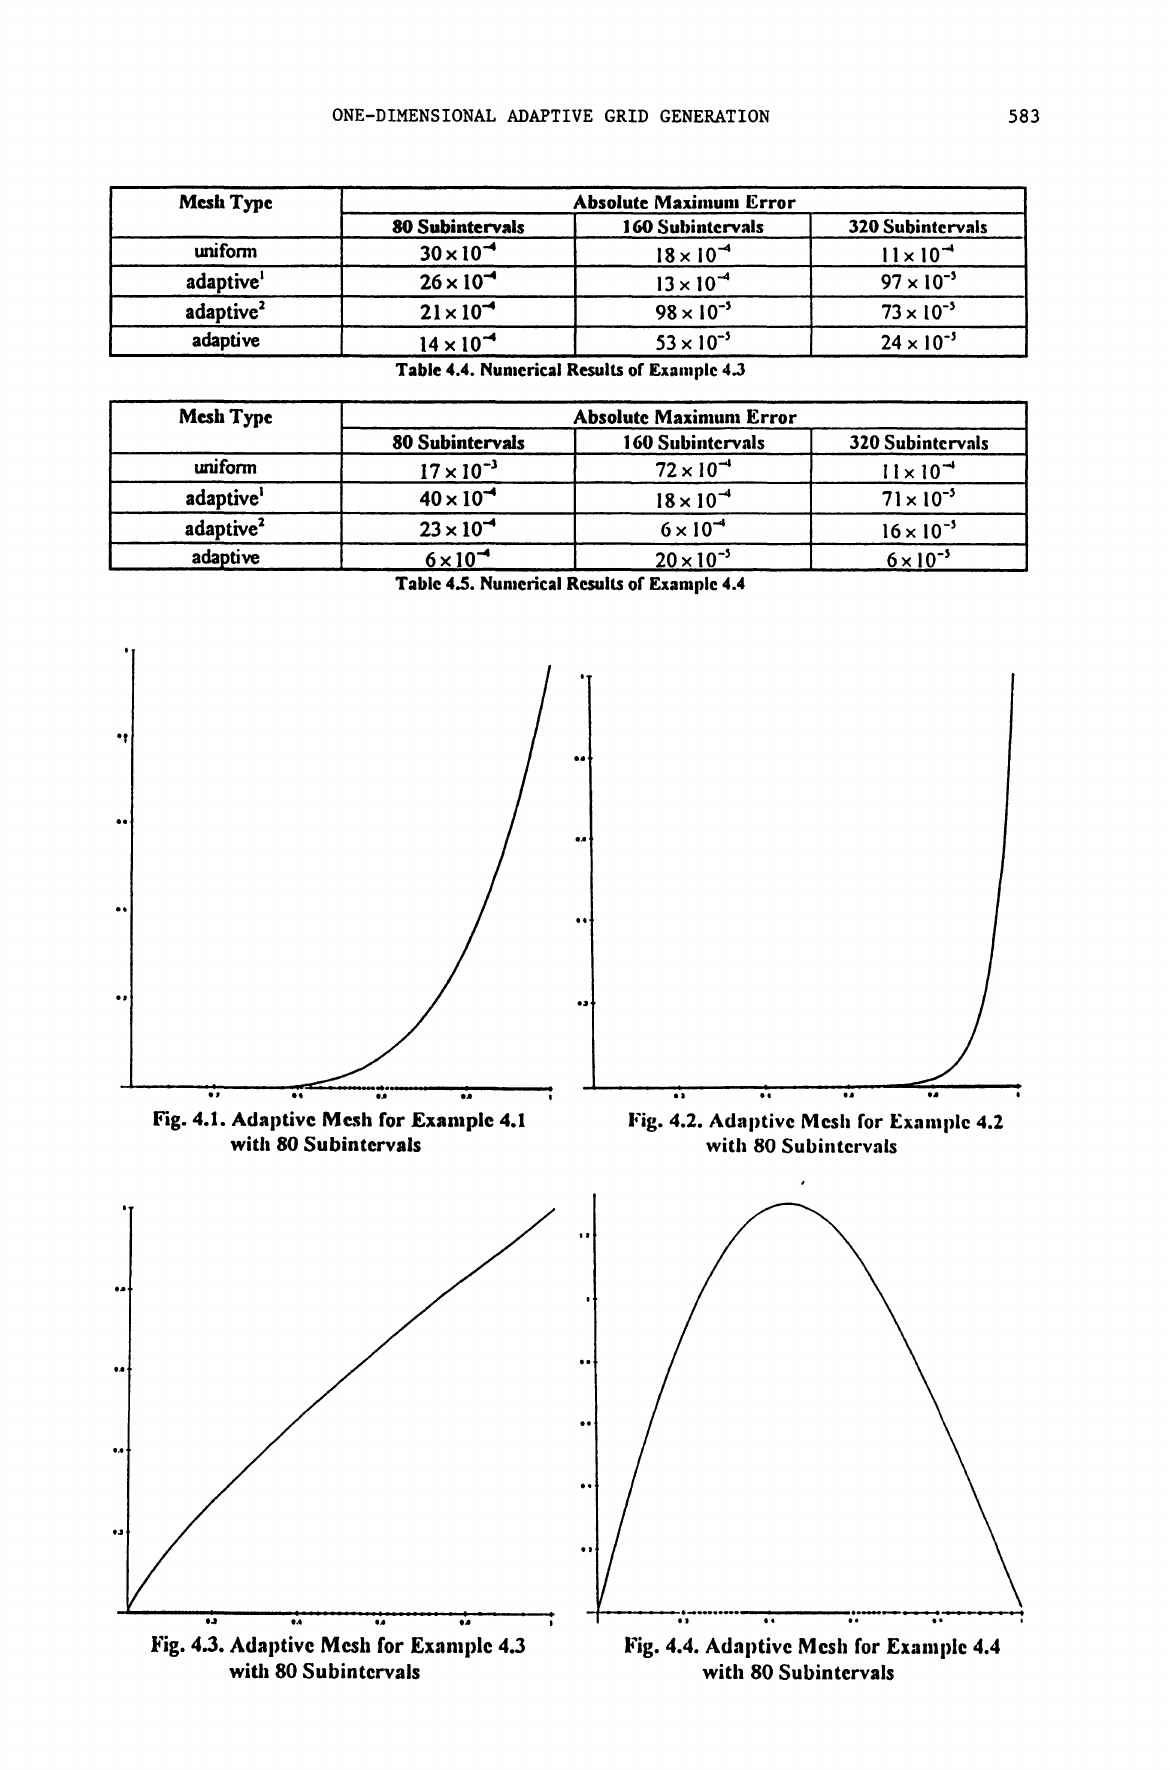
Fig. 4.4. Adaptive Mesh fr Example 4.4 with 80